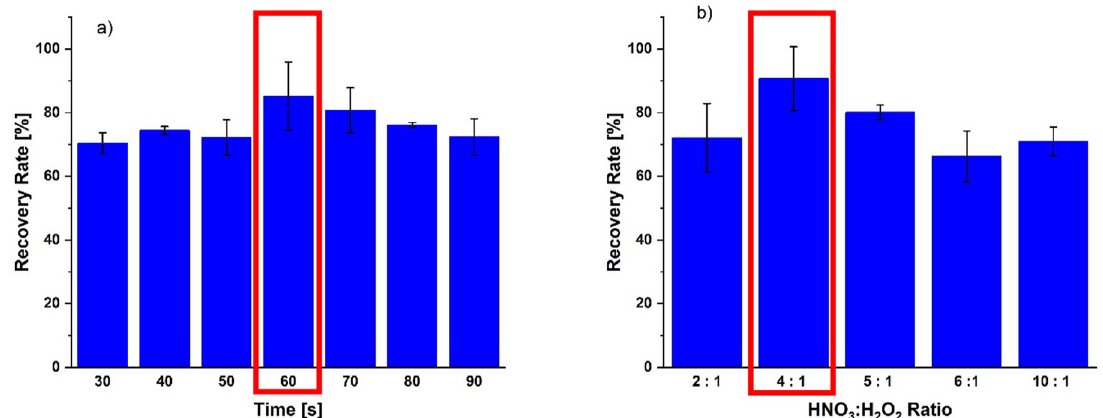
Fig 3. Optimization of microwave assisted acid digestion. a) time of digestion; b) hydrogen peroxide to nitric acid ratio. The optimal settings are